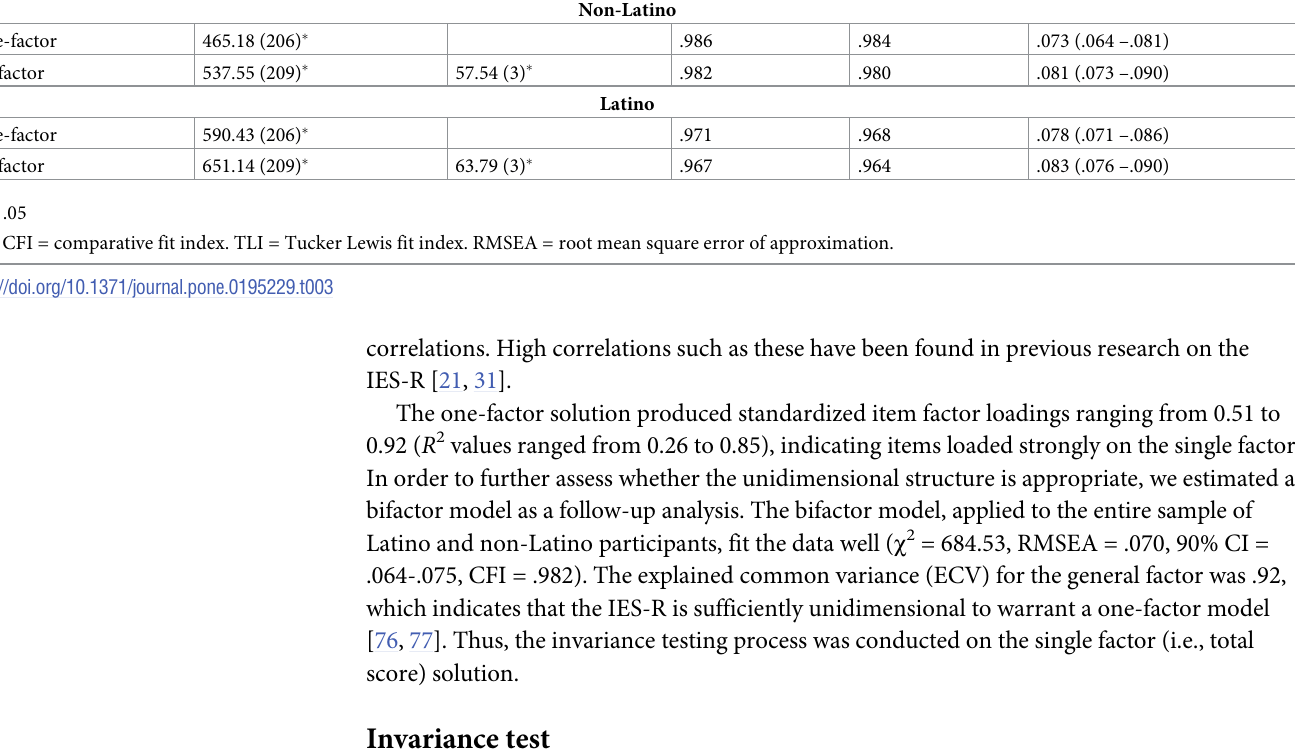
Table 3. Single sample CFA fit indices.